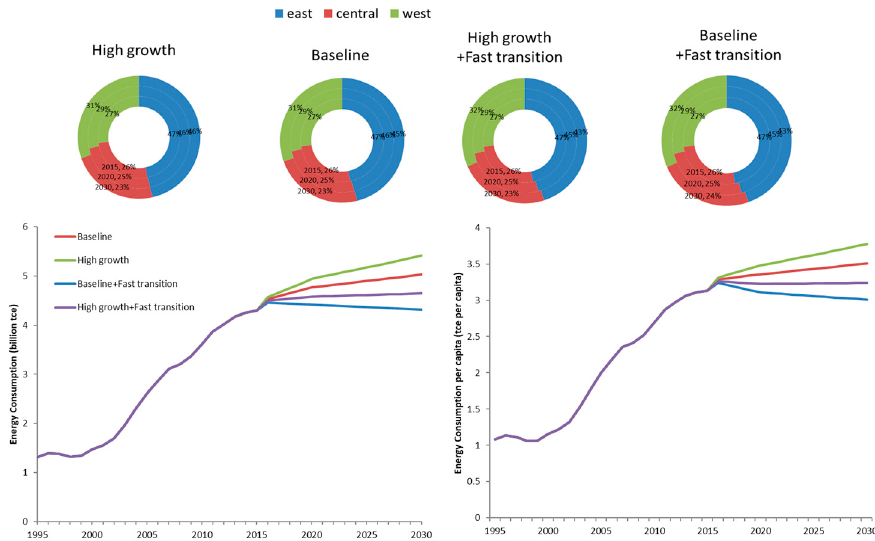
Figure 4. Energy Consumption History (1995–2015) and Forecast (2016–2030) under Four Scenarios with Regional Energy Consumption Share in 2015, 2020, and 2030.